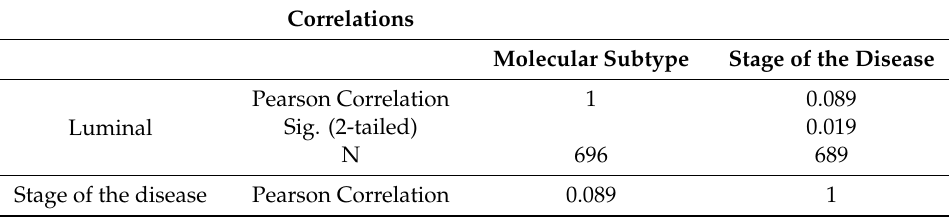
Table 9. Correlation between stage and molecular